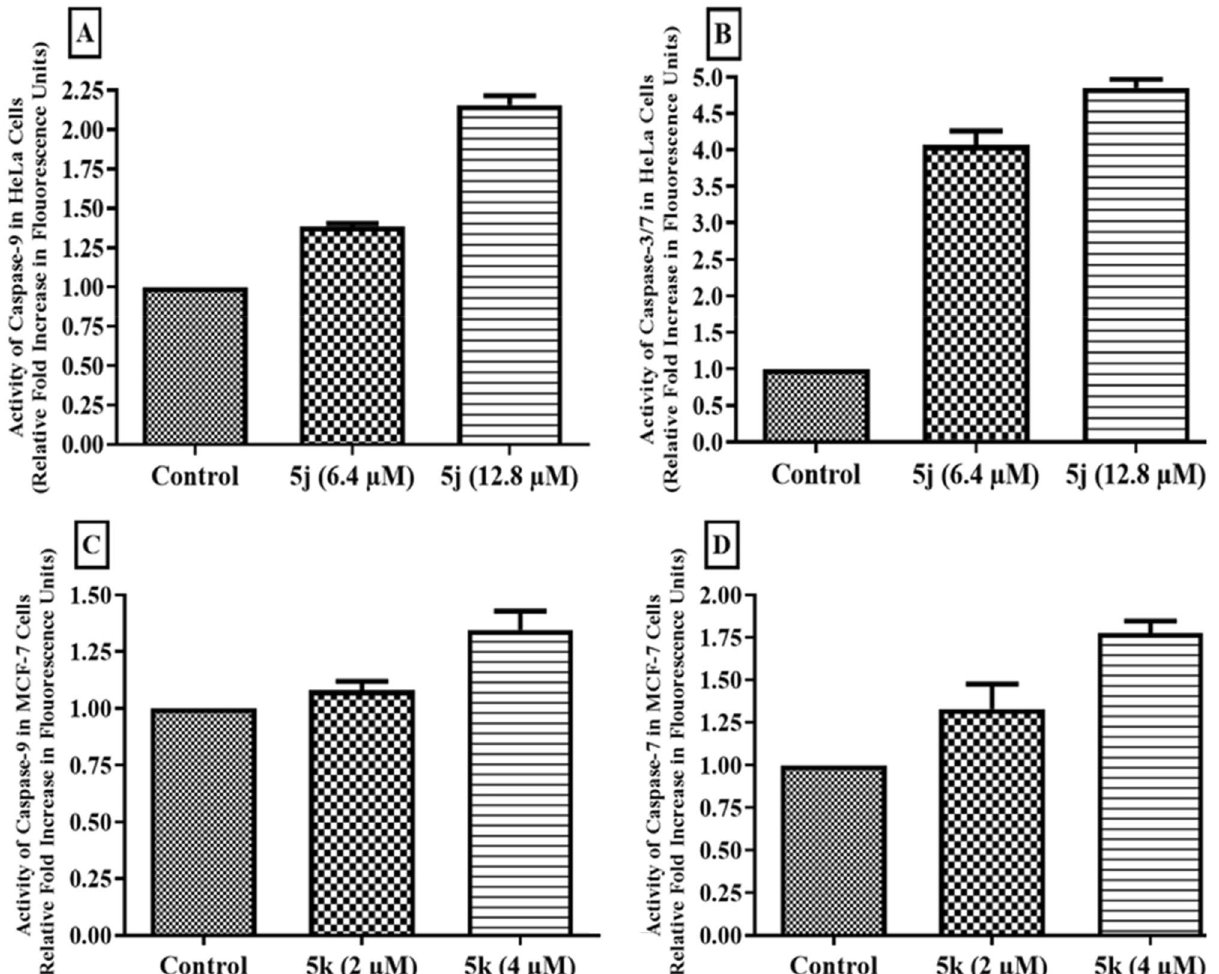
Figure 9. Fold increase in activity of ( A ) caspase-9 and ( B ) caspase-3/7 in HeLa cells after treatment with compound 5j. Fold increase in ( C ) caspase-9 and ( D ) caspase-7 in MCF-7 cells after treatment with compound 5k . Data are represented as mean ± SD in replicate of three. * p ˂ 0.05, ** p ˂ 0.01, *** p ˂ 0.001 versus control group (n =